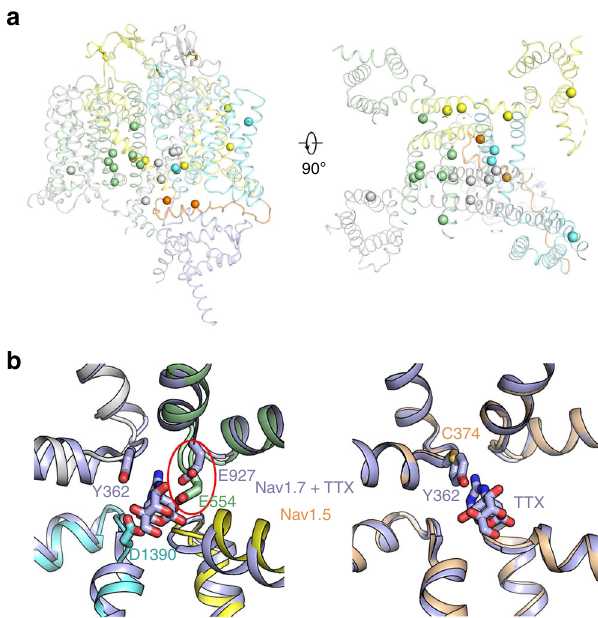
Fig. 7 Disease mutations mapping on NALCN and TTX incompatibility of NALCN. a Please also refer to Supplementary Table 3 for a summary of the disease-related mutations on human NALCN. The C α atoms of the residues whose mutations lead to human diseases are mapped to the structure of NALCN and shown as spheres. The mapping is shown on both sides and extracellular views. b Superimposition of the pore helices and SF of NALCN with that of TTX-bound Na v 1.7 (left). The determinant Tyr362 for TTX coordination in Na v 1.7 is not conserved in NALCN and the structural deviations in the pore region of NALCN also result in potential clashes with the TTX binding site, making NALCN and TTX incompatible. As a comparison, despite lack of the determinant Tyr, TTX-insensitive Na v 1.5 shows a similar backbone structure of pore helices and SF to that of TTX-bound Na v 1.7, thus retains a lower binding af fi nity to TTX